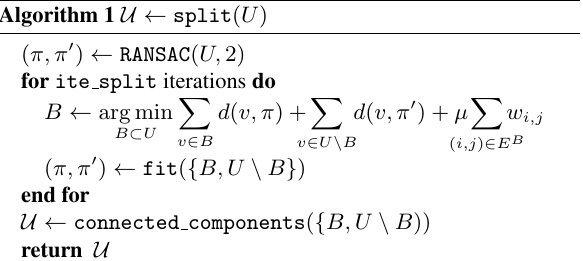
Algorithm 2 (cid:96) 0 -plane